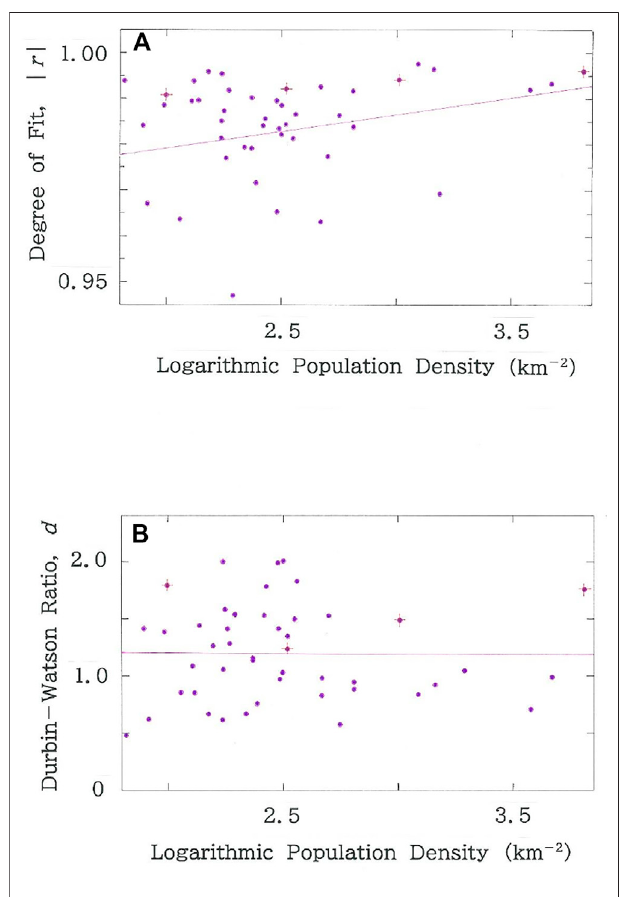
FIGURE 5 | Dependence of (A) degree of fi t, | r |, and (B) Durbin-Watson ratio, d , on the common logarithm of population density (km − 2 ) for the entire prefectureinJapan.Thepurplelineintheindividualcrosssectionindicatesthe regression line. The red crosses that are superimposed on the dots highlight the four prefectures in Tables 2 and 3